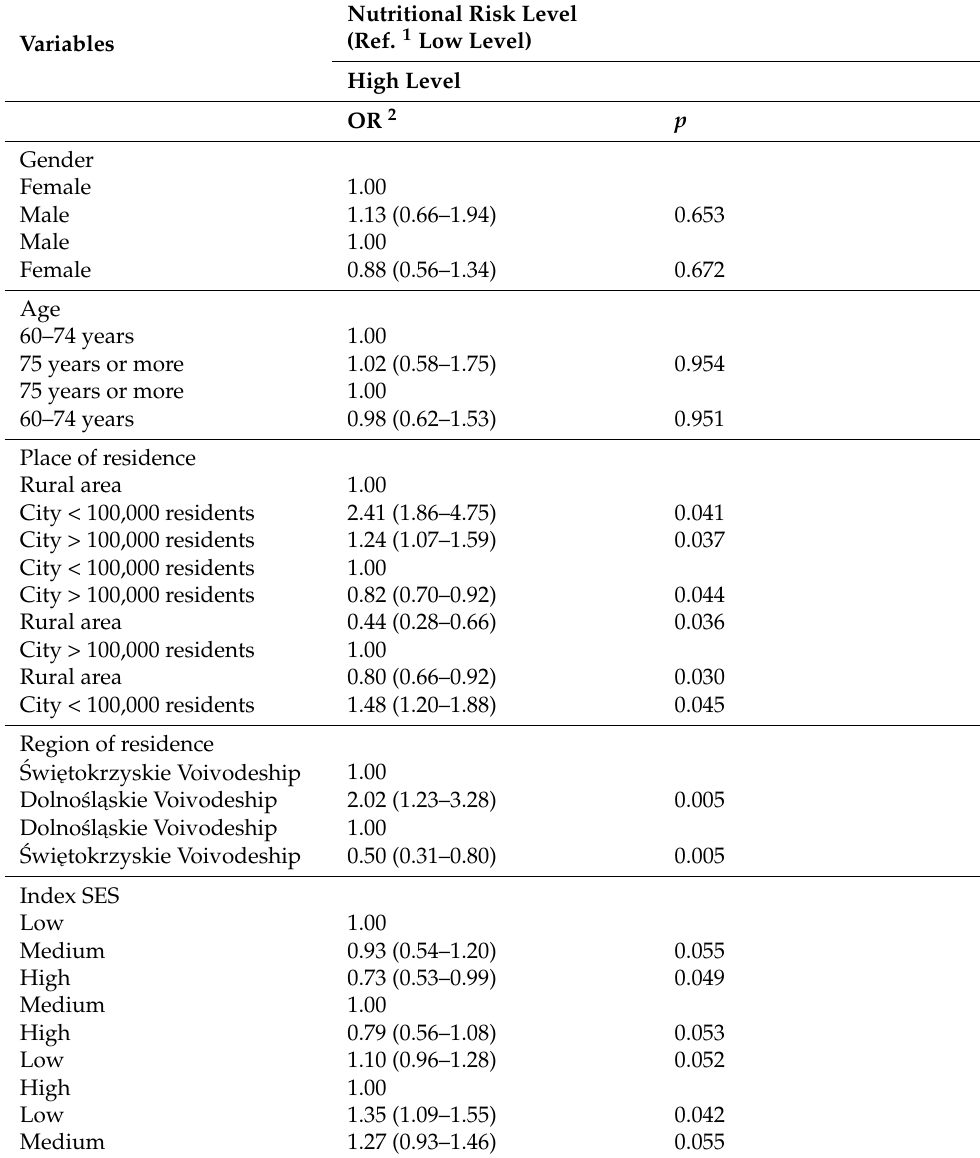
Table 3. Associations between nutritional risk level and demographic characteristics and SES index in the study sample (adjusted odds ratios with 95% confidence